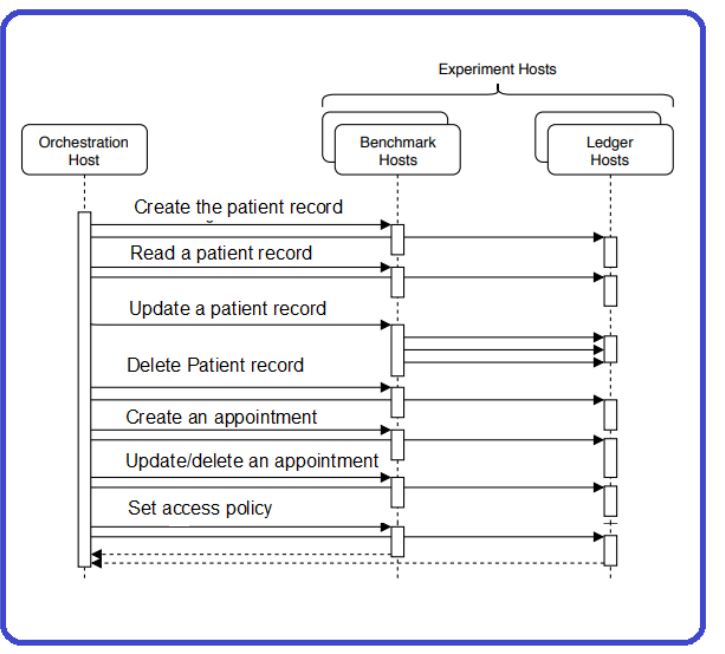
Figure 17. Process flow for patient record